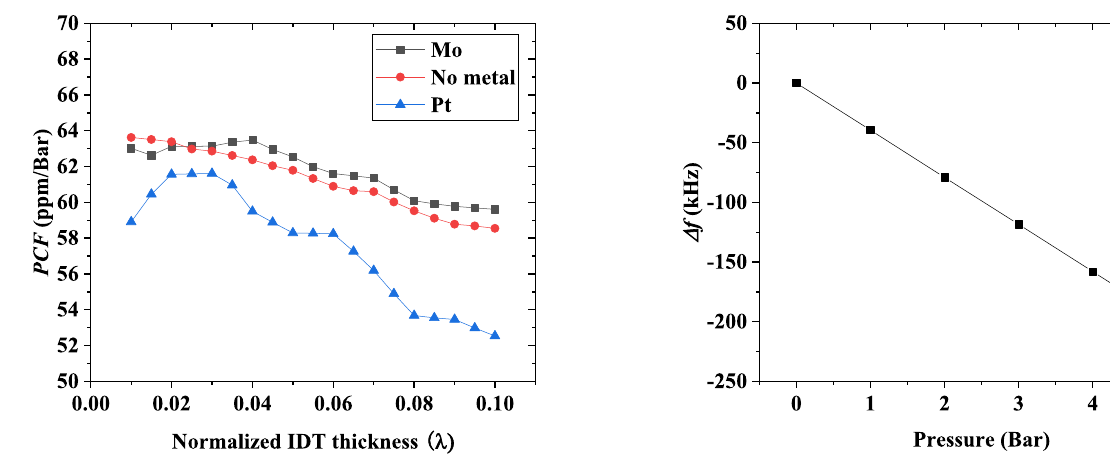
Figure 7. Dependence of D f on